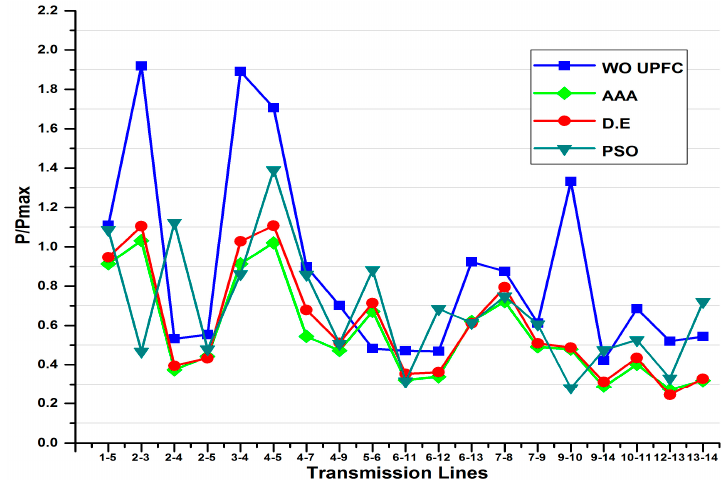
Figure 4. Voltage magnitudes for Case Study-1 by AAA, D.E and PSO when line 1 is trip. Energies 2017 , 10 , 1738